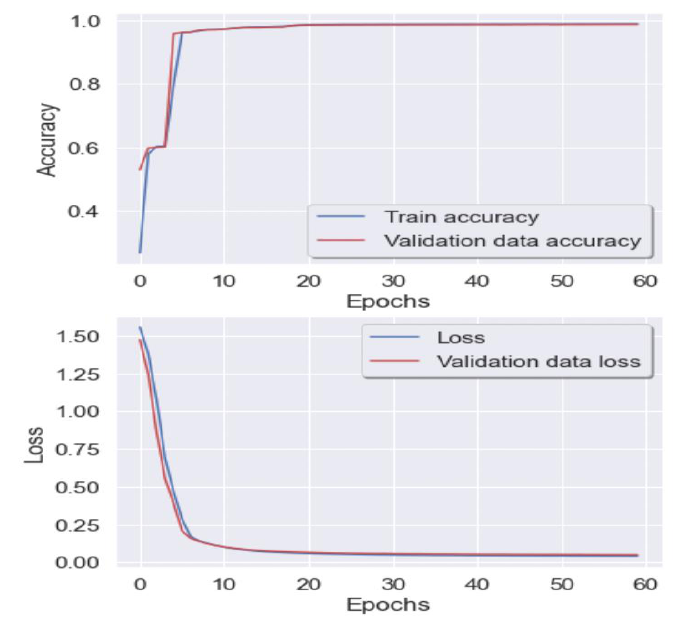
Figure 5. Evolution of loss and accuracy in